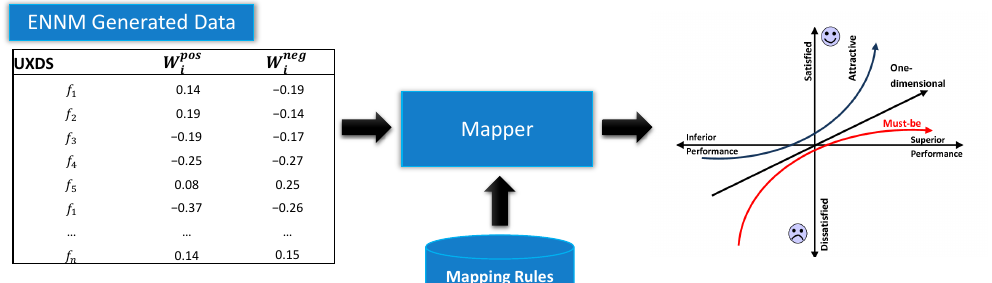
Figure 10. Mapping of UDXs on Kano